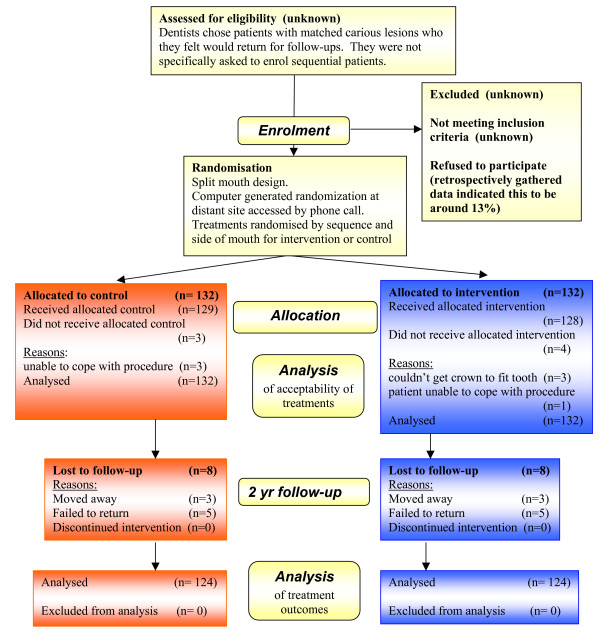
CONSORT (Consolidated Standards of Reporting Trials) diagram showing the flow of participants through each stage of the randomized trial.